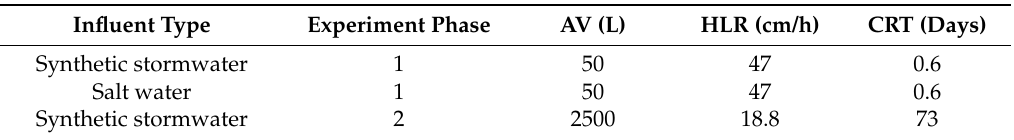
Table 3. Average volume per column (AV) and hydraulic loading rate (HLR) used during the two phases of the study. CRT stands for column running time.